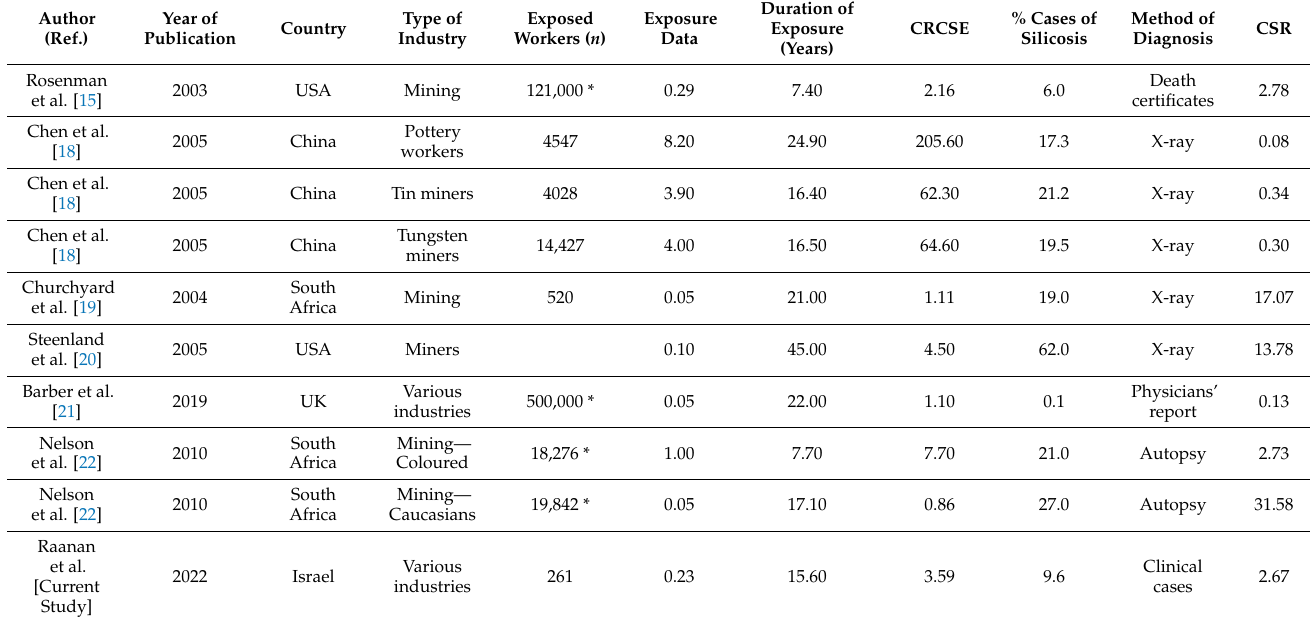
Table 5. Silicosis rate in different industries according to